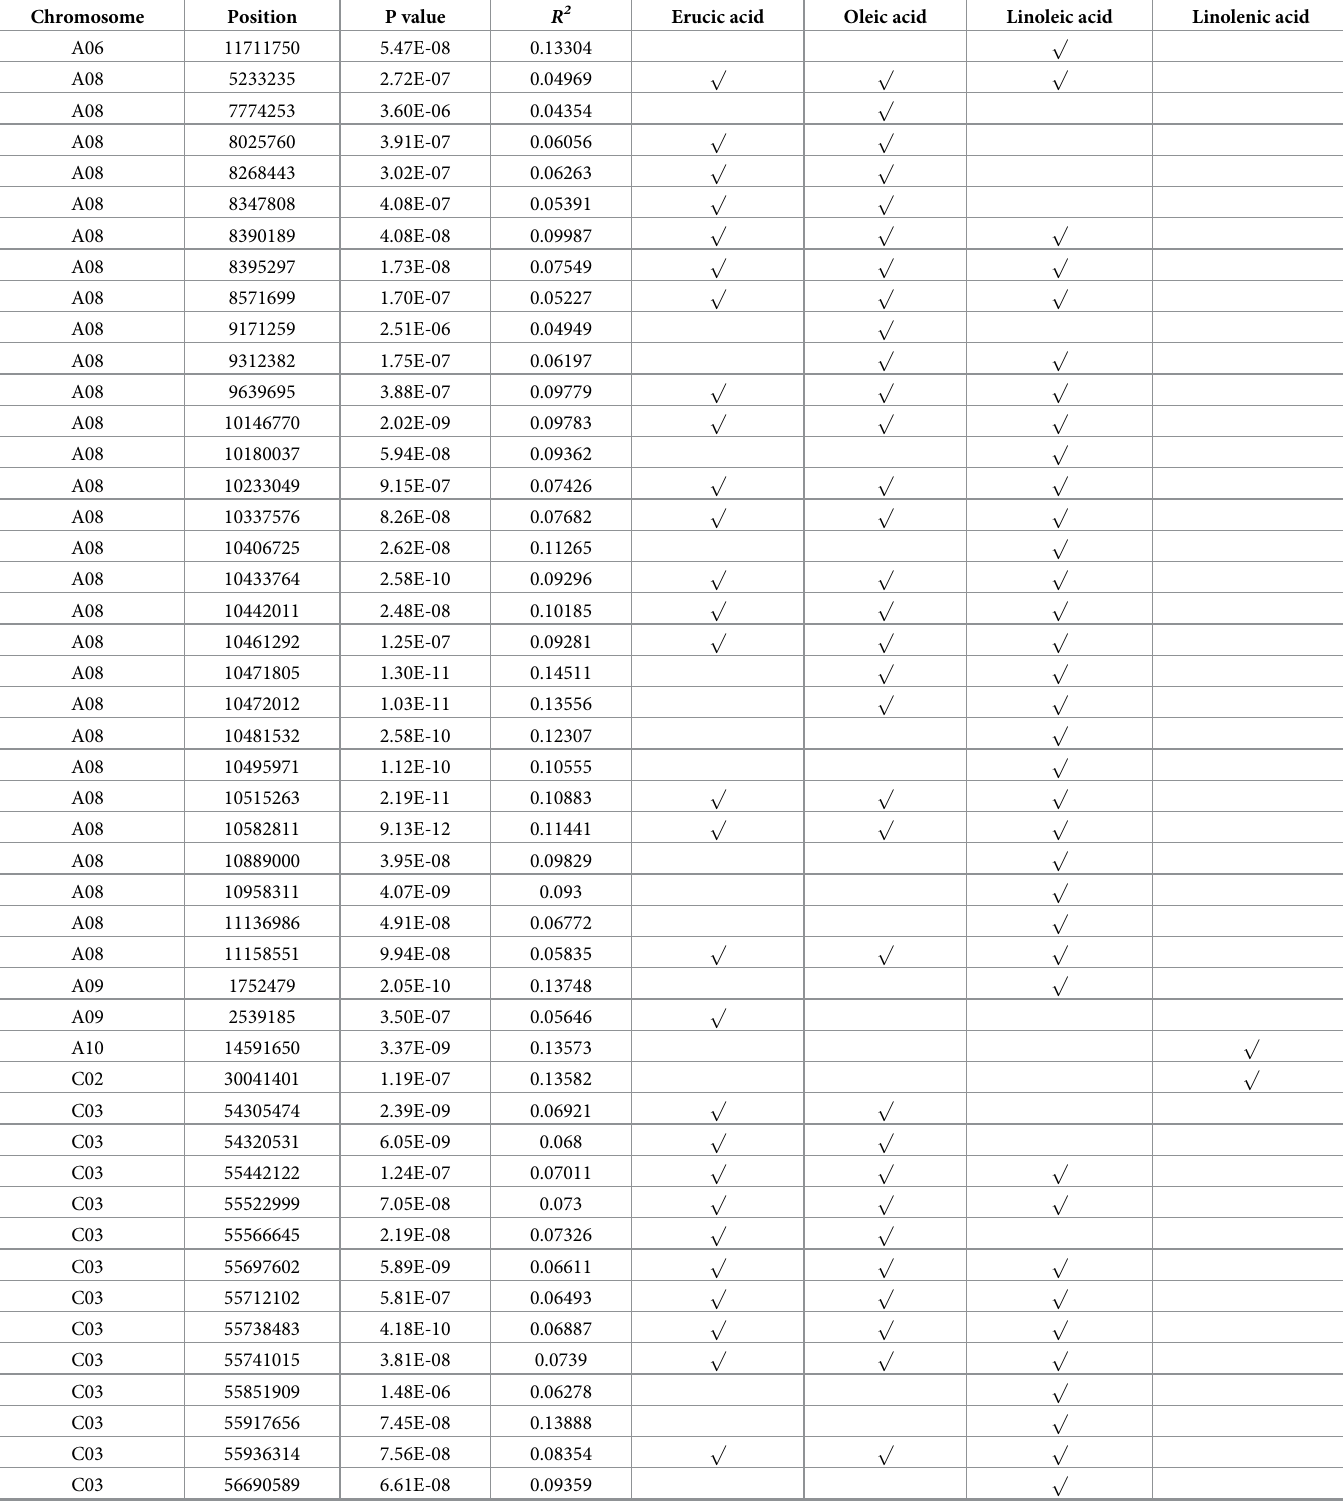
Table 5. Peak SNPs associated with four fatty acid contents in seed of B . napus .